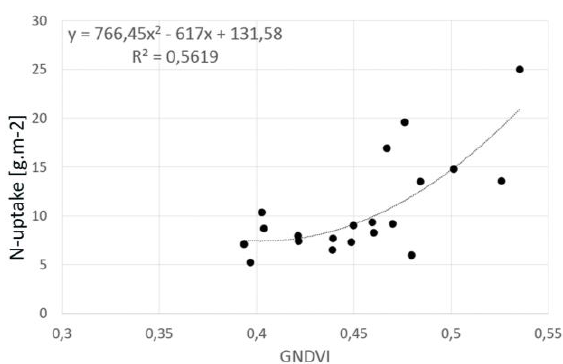
Figure 4. Scatter plot of GNDVI values and dry biomass from UAV image in BBCH 32